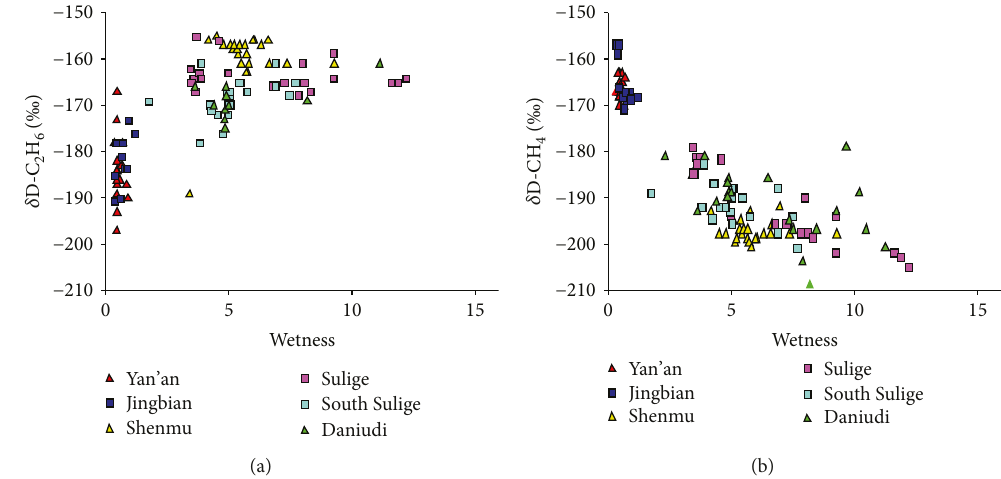
Figure 11: (a) δ D-C H versus wetness of the gases from di ff erent gas fi elds in the Ordos Basin; (b) δ D-CH 2 6 di ff erent gas fi elds in the Ordos